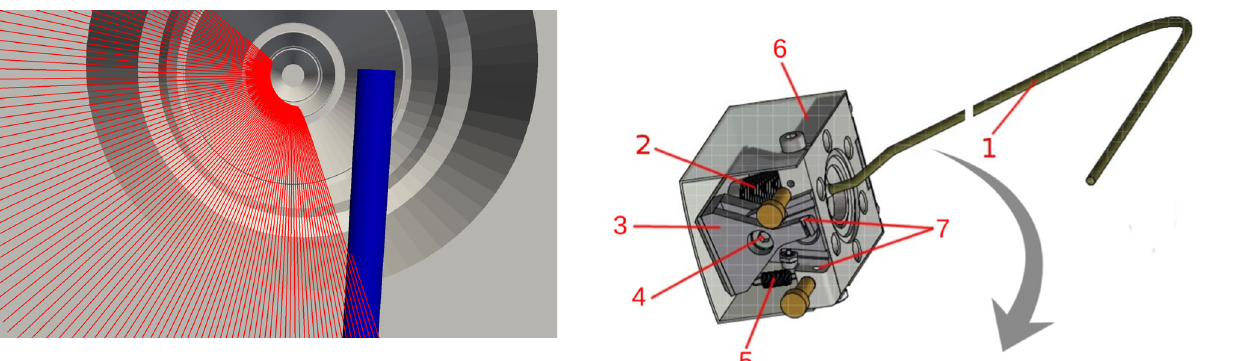
Fig. 5 Simulatedtrackofatrappedelectron(red)uptothepointwhere it hits the electron catcher (blue) (looking down the beamline). Simu- lation is done with the Kassiopeia software [26]